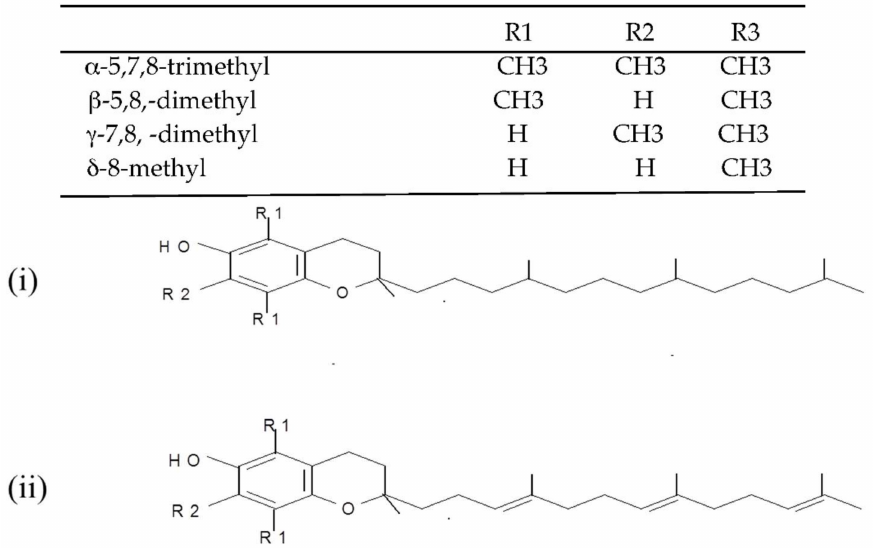
Figure 2. Chemical structures of the E vitamers (tocopherols-i and